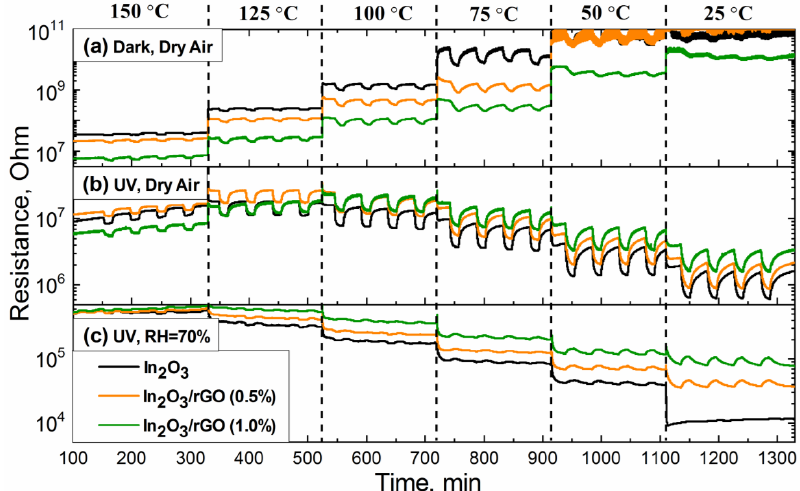
Figure 6. Dynamic changes in sensors ’ resistance with periodic changes in the gas phase composi- tion (20 ppm NH 3 – purified air) in the temperature range of 150 – 25 °C under various experimental conditions: ( a ) under dark conditions with dry air; ( b ) under UV illumination with dry air; and ( c ) under UV illumination with a relative humidity of 70% (RH = 70%).